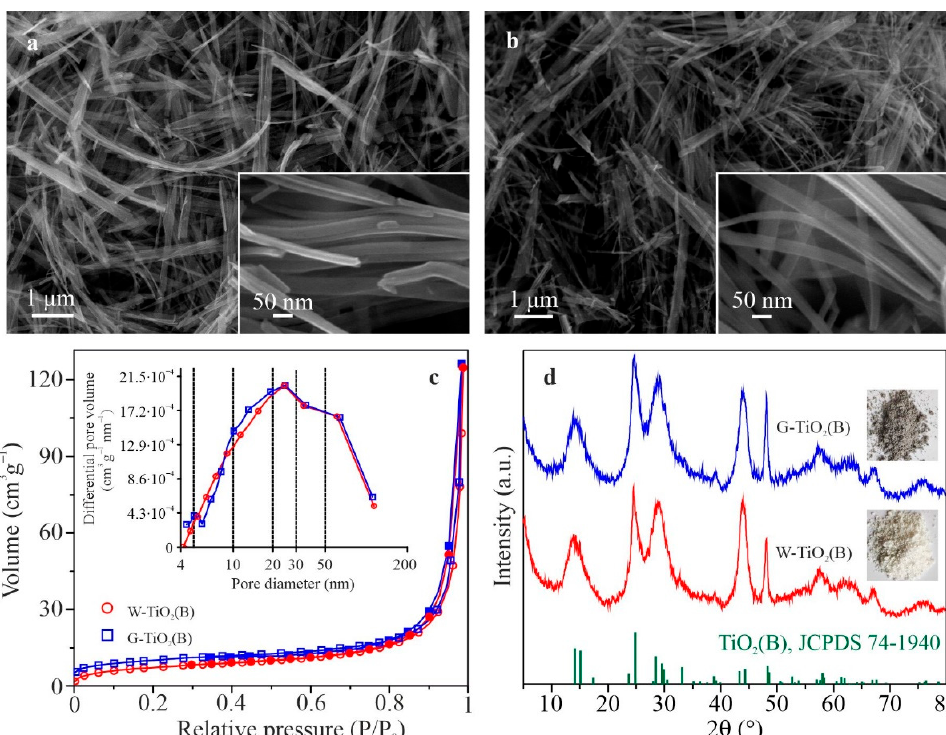
Figure 1. SEM-images at different magnification for W-TiO 2 (B) ( a ) and G-TiO 2 (B) ( b ), low–temperature N 2 adsorption-desorption isotherms with pore size distribution plots (insert) ( c ), and XRD patterns with photos (insets) of synthesized products ( d ).